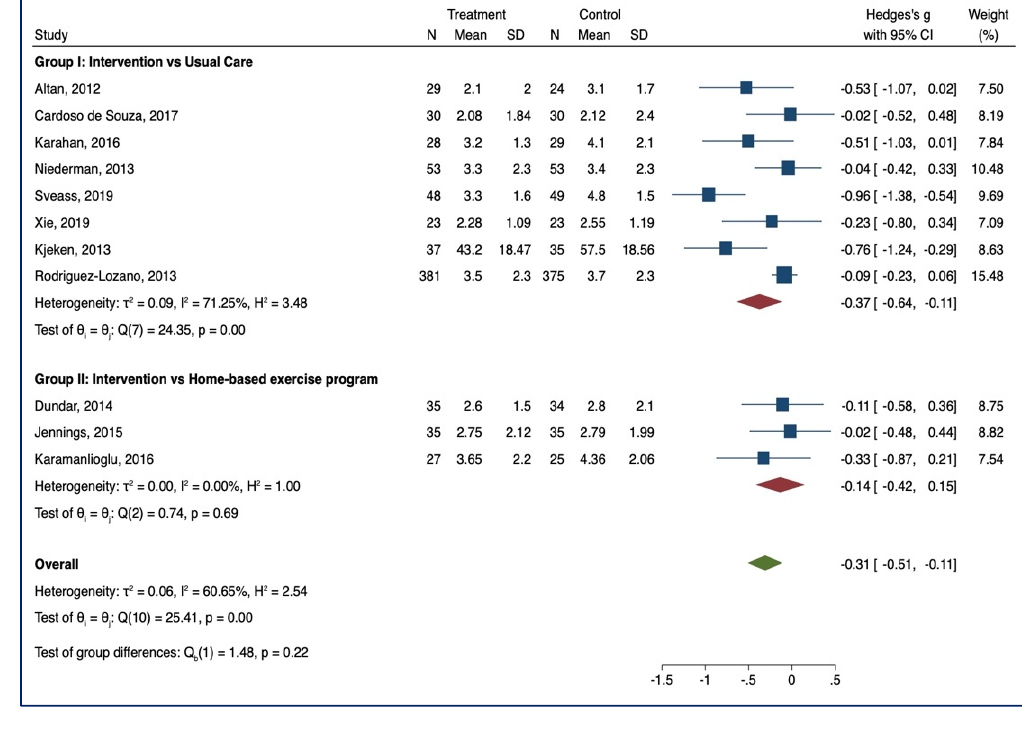
Figure 3. BASDAI—Forest Plot.